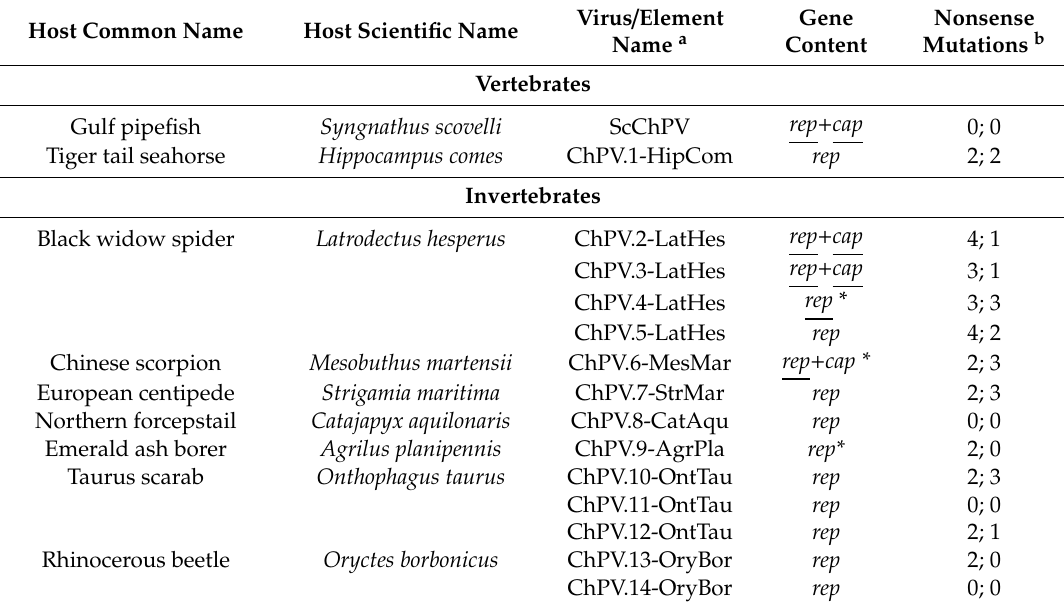
Table 1. Novel ChPV sequences identified in this